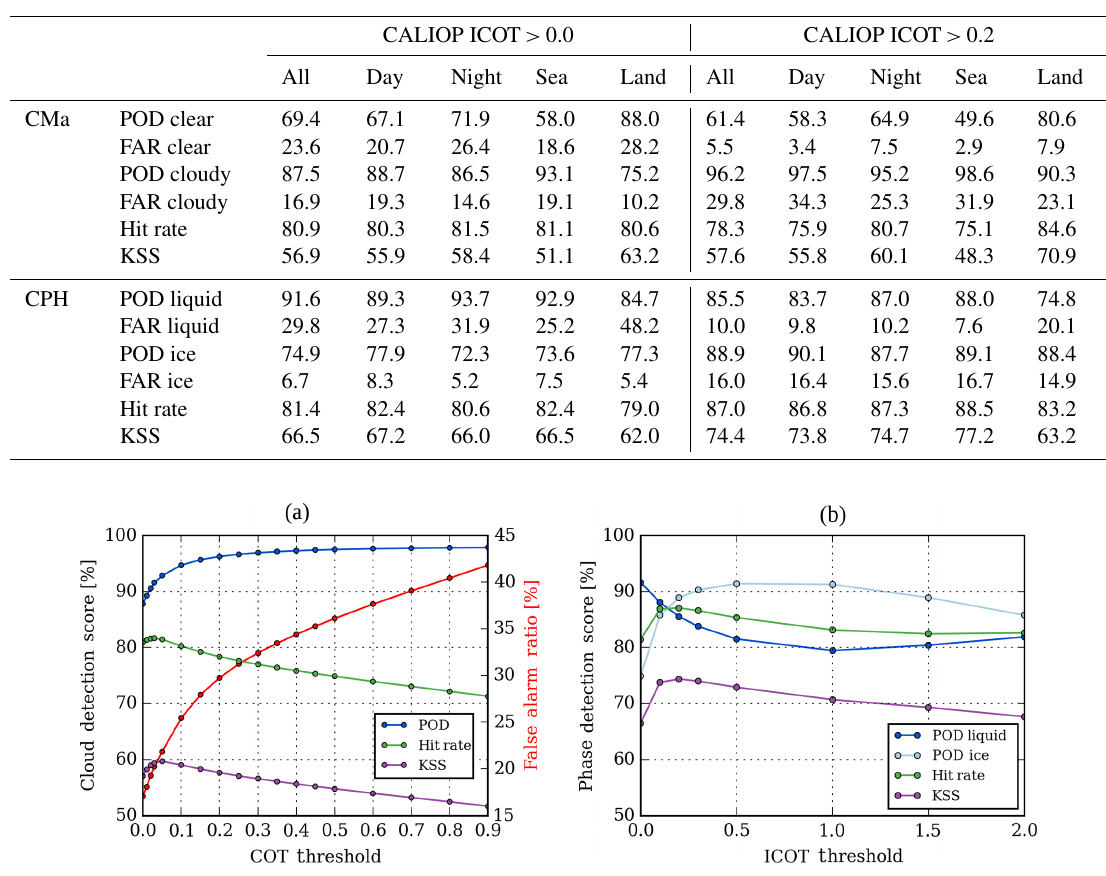
Figure 1. (a) CLAAS-2 cloud detection scores as a function of the COT threshold used to discriminate clear and cloudy CALIOP observa- tions. KSS denotes the Hanssen–Kuiper skill score. (b) CLAAS-2 cloud phase detection scores as a function of the integrated COT (ICOT) threshold, which determines the reference cloud